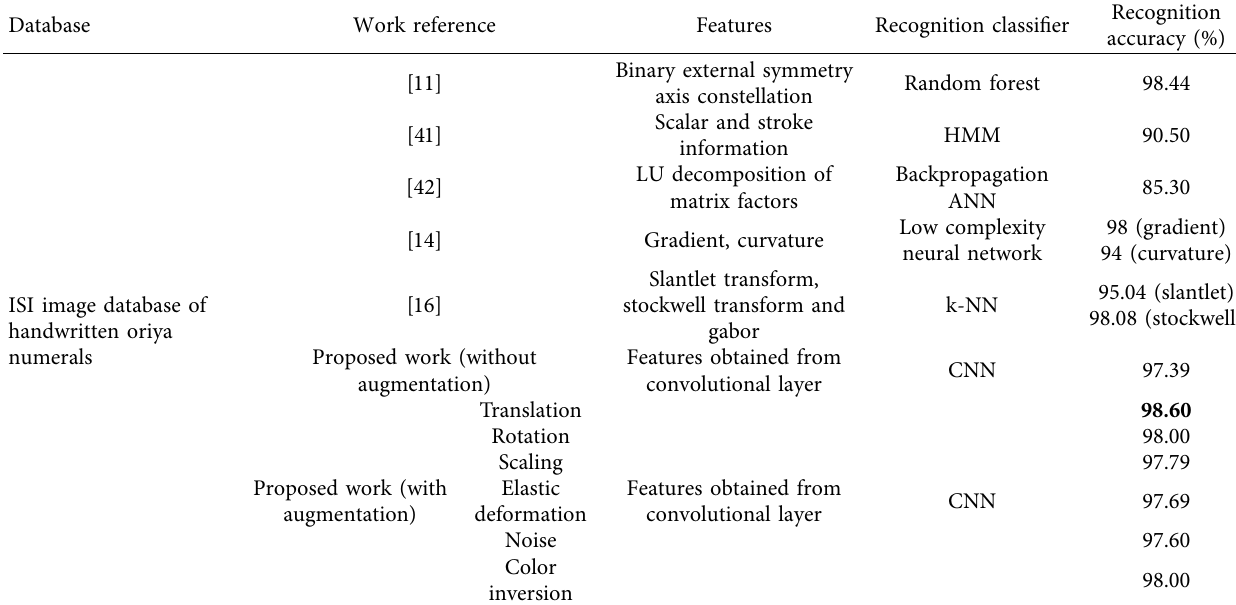
Table 10: Performance comparison on handwritten ISI image and Odia numeral